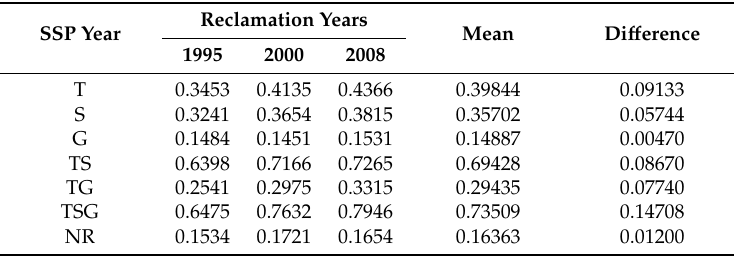
Table 8. Descriptive statistics of forest spatial structural parameters (SSPs) in different reclamation years from different forest configuration types.